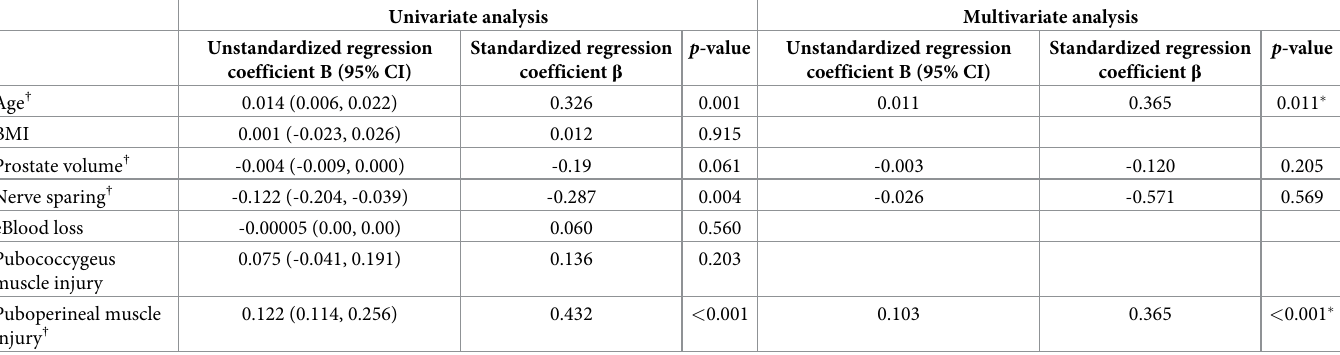
Table 3. Predictors of incontinence after removal of the urethral catheter. Results of univariate and multivariate